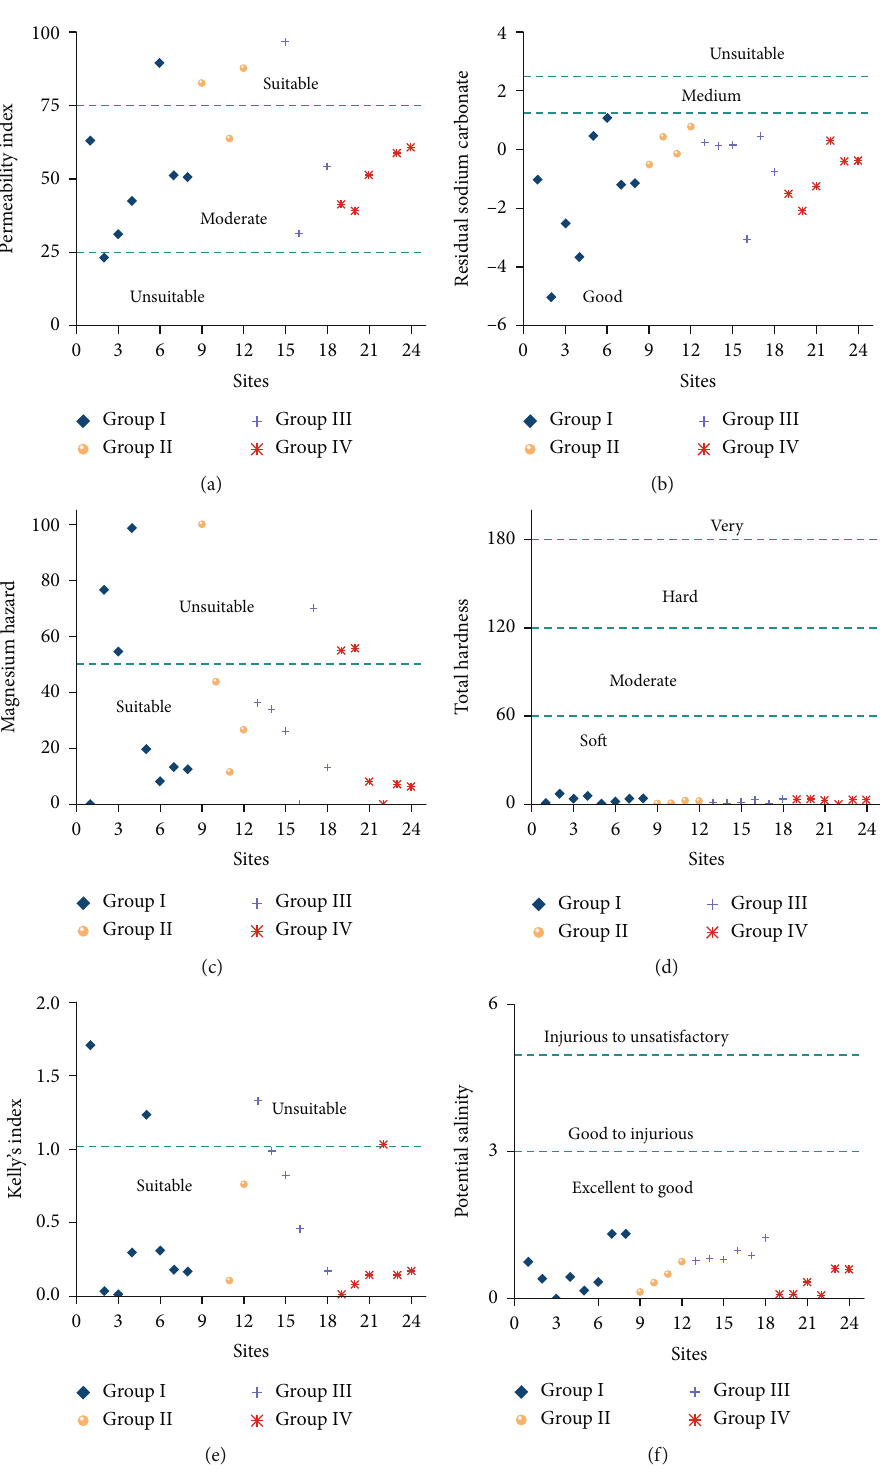
Figure 13: Irrigation water quality-related